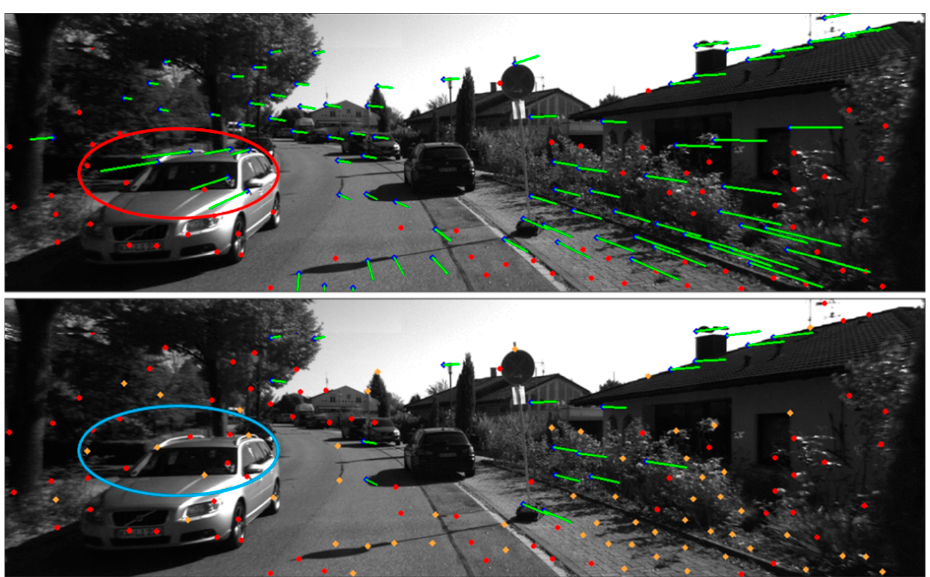
Figure 10. Top: before optimization (top image). Bottom: after optimization (sequence 09; frame 60).